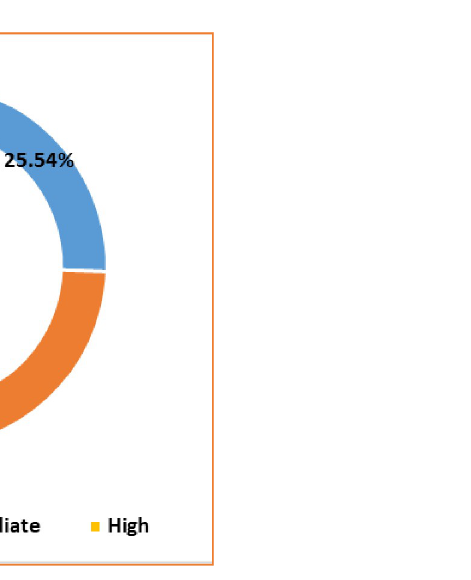
Fig 1. Prevalence of WPV among the female nurses (n =